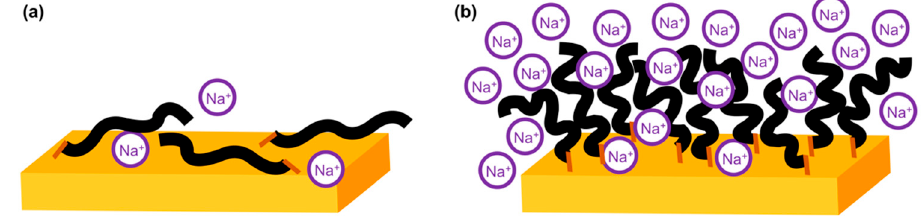
Figure 3. Sketches of C 6 -ssDNA SAMs immobilized in ( a ) 1 mM NaCl and ( b ) 1 M NaCl TE